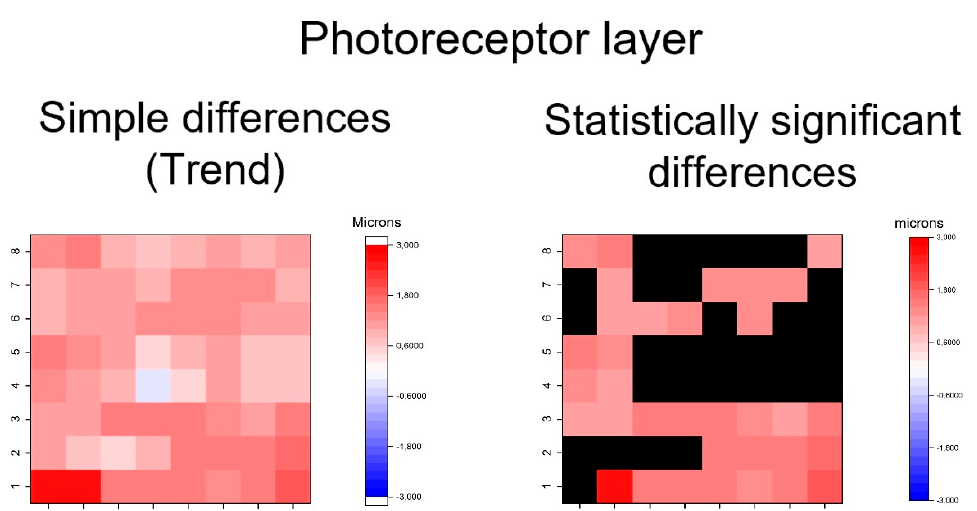
Figure 9. Heatmaps showing di ff erences in photoreceptor layer. Left map: this heatmap represents simple di ff erences in the mean thickness between the OHT group and early POAG group in each superpixel, giving an idea of the trend. Right map: the heatmap represents the statistically significant di ff erences ( p < 0.05) of the mean thickness between groups in each superpixel. No significant di ff erence ( p ≥ 0.05) is represented in black. Range of significant OHT-POAG di ff erences in superpixels between 1.08 and 2.63